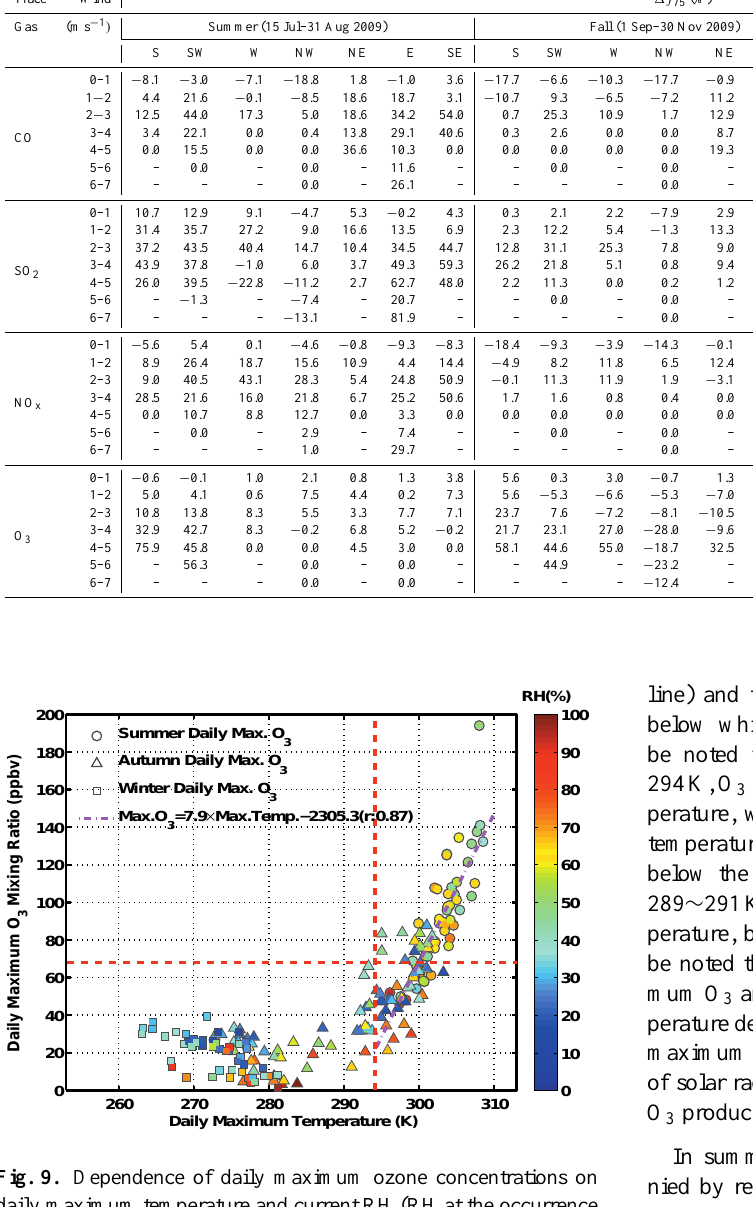
Table 3. Wind Speed (WS) and Wind Direction (WD) distribution of frequency increment 1f . Calculation methods are given in Sect. 2.5. Trace Wind